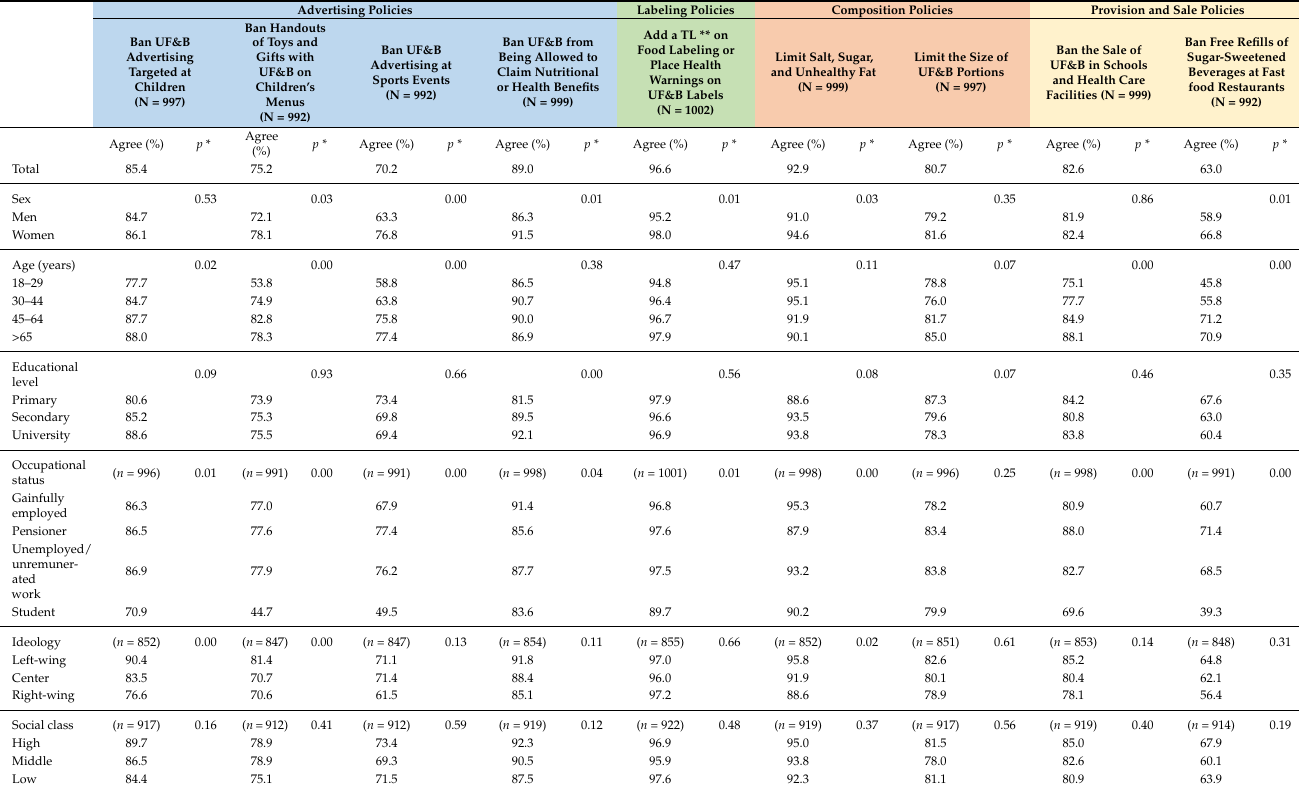
Table 2. Percentage agreement of the Spanish population with food-and-drink advertising and labeling policies, 2018.